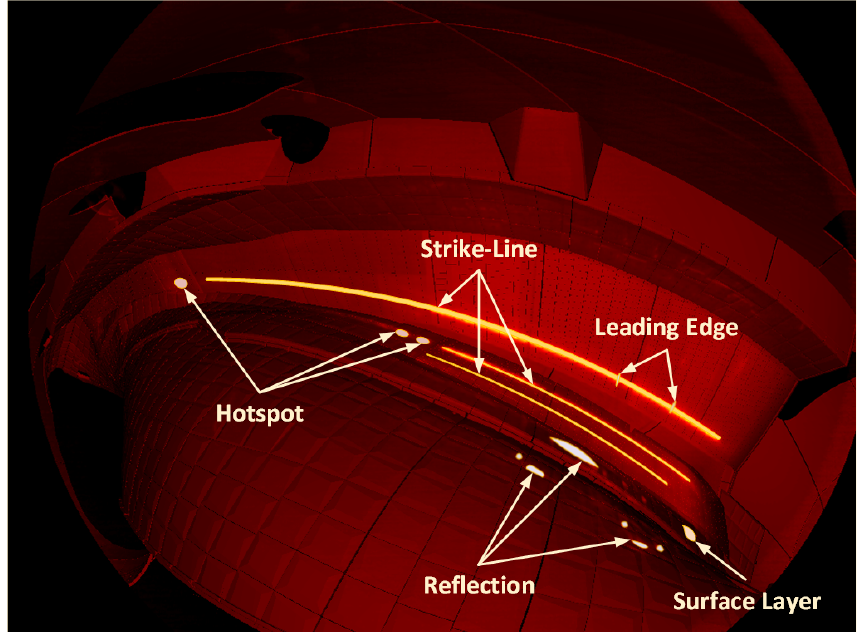
Figure 1. Exemplary thermal events in the Wendelstein 7-X (W7-X). The authors overlaid thermal events onto the stellarator model and coloured surface temperature from the available dataset for visualisation purposes, similarly to the figure in